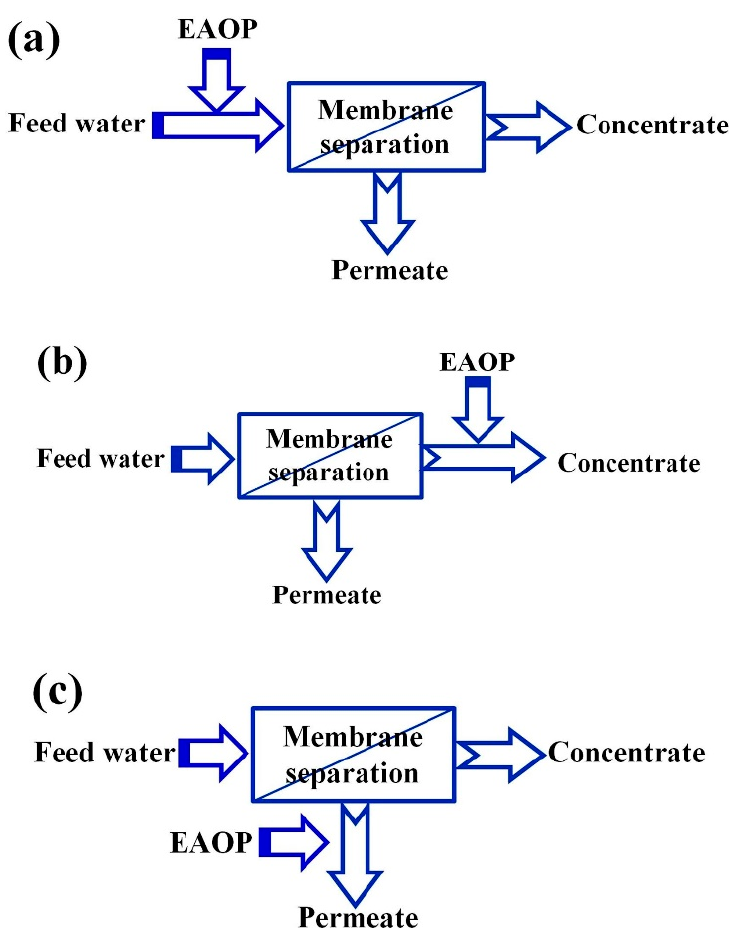
Figure 1. Coupling of membrane processes with electrochemical advanced oxidation processes (EAOPs, the two-stage processes): ( a ) Pre-treatment of feed; ( b ) Post-treatment of concentrate; ( c ) Advance treatment of permeate [3].